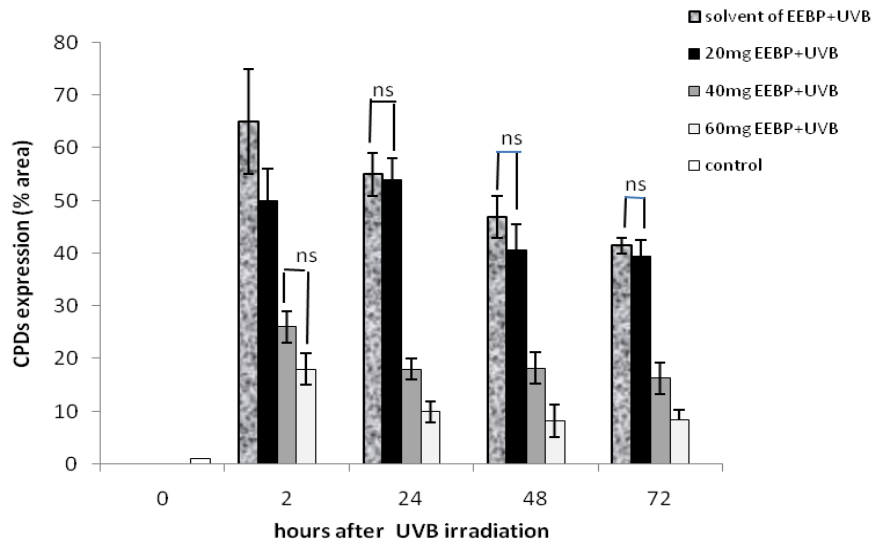
Figure 2. The representation of semi-quantitative analyze of effect of EEBP against CPDs